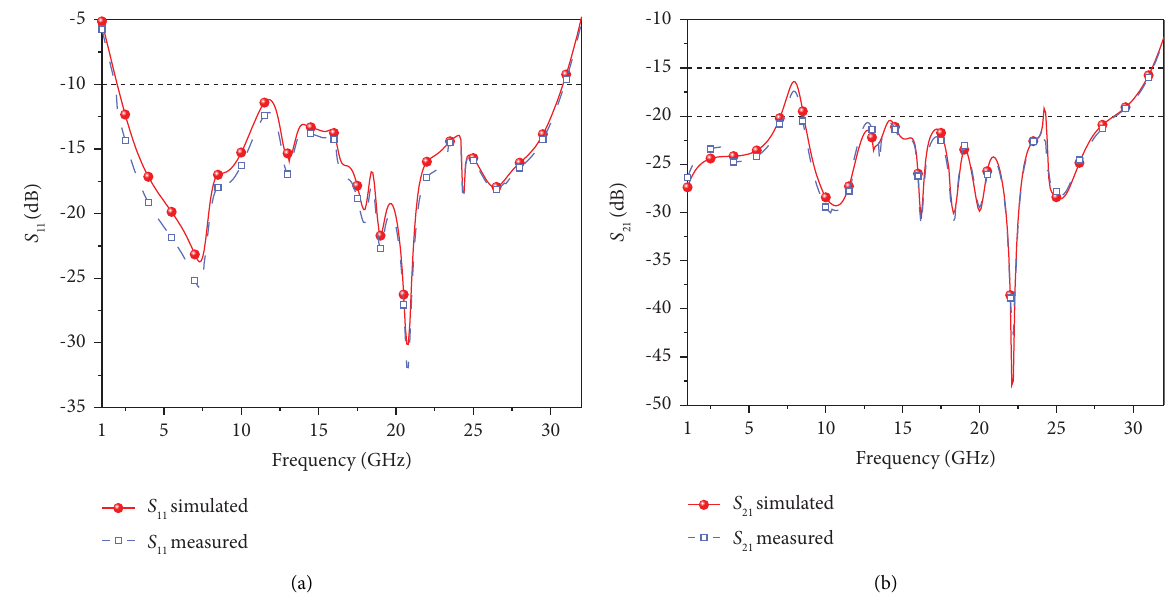
Figure 12: Simulation and measurement of S 11 and S 21 . (a) S 11 simulation and measurement. (b) S 21 simulation and